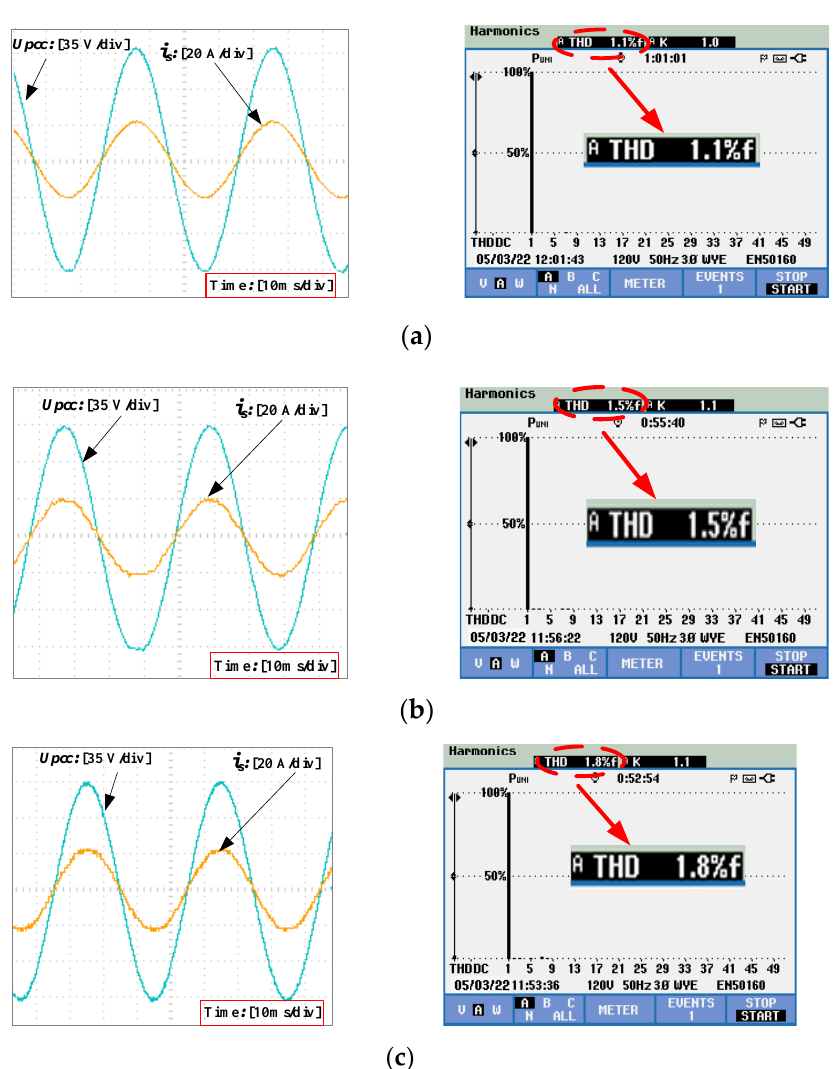
Figure 11. Waveform of U P CC , i s and the THD of the grid current with different Z g . ( a ) Z g = 0 mH; ( b ) Z g = 0.9 mH; ( c ) Z g = 1.8 mH.